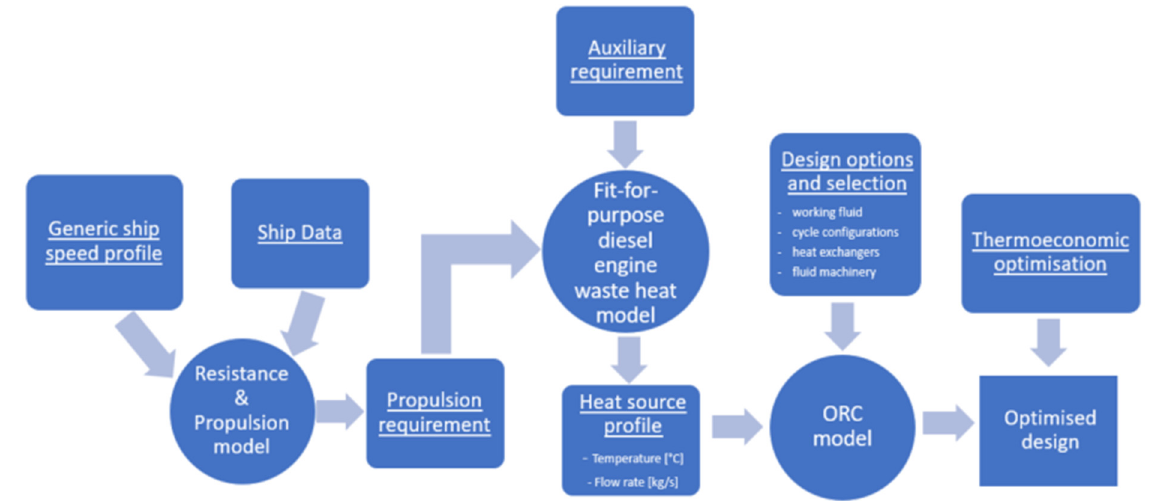
Figure 2. Outline of the proposed methodology.